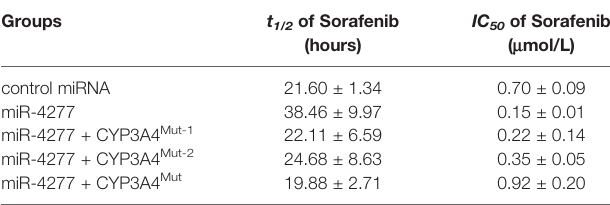
TABLE 2 | The effect of miR-4277 on Sorafenib in cultured MHCC97-H cells. Groups t 1/2 of Sorafenib (hours)